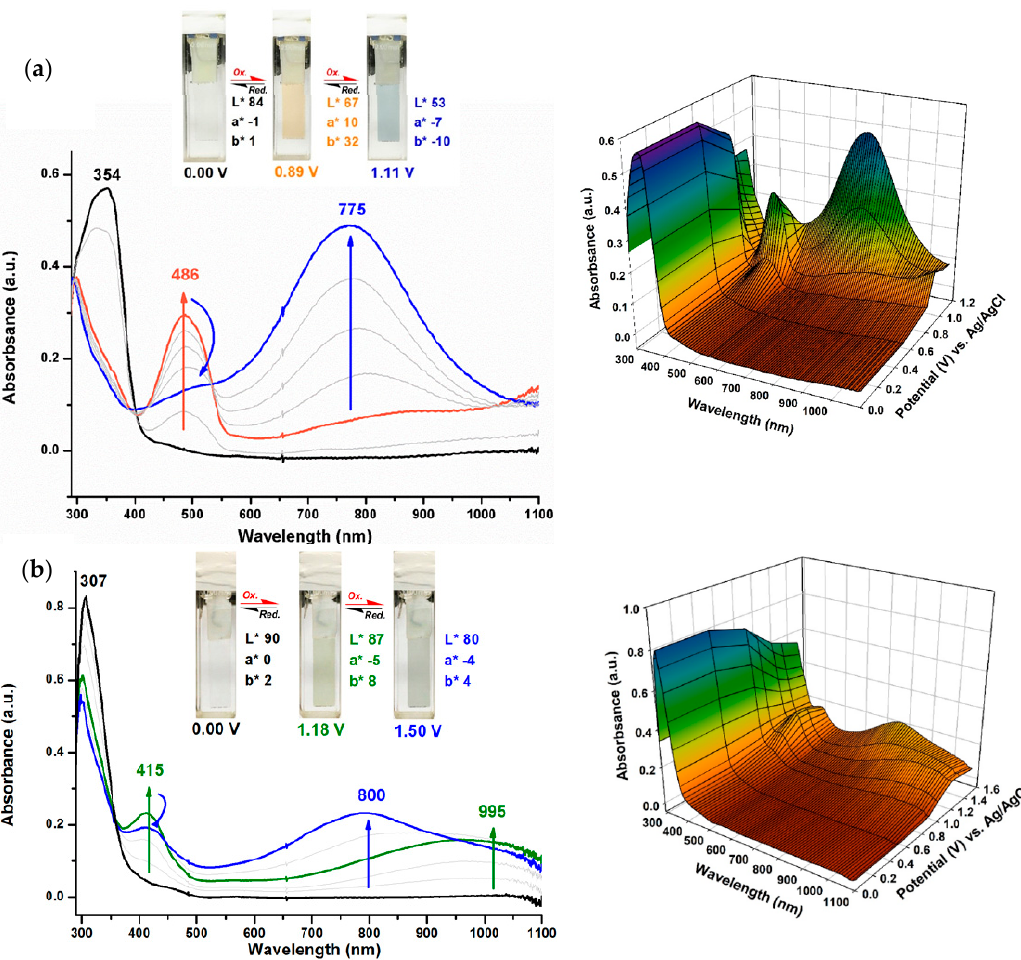
Figure 16. Spectroelectrograms and color changes of ( a ) TPA–TPPI and ( b ) NPC–TPPI thin films on ITO-coated glass in 0.1 M Bu 4 NClO 4 /CH 2 Cl 2 at various applied voltages.